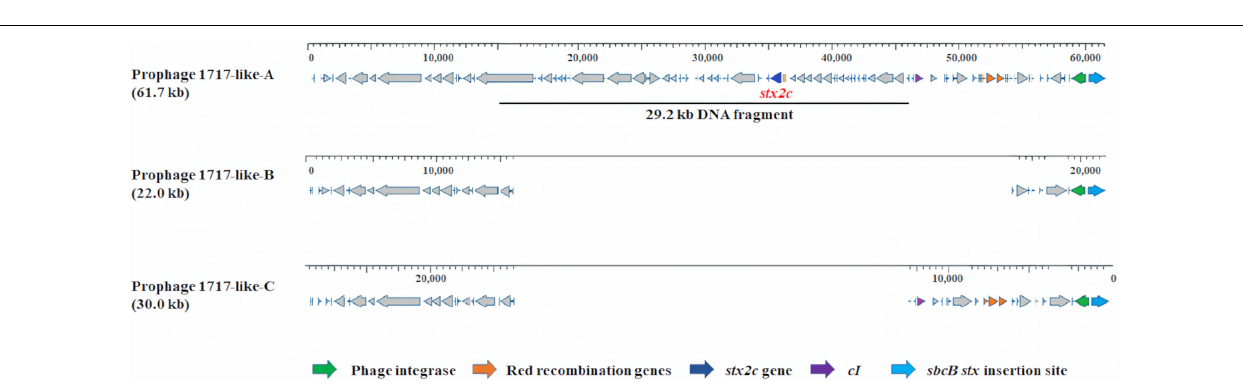
FIGURE 3 | Prophage comparison at sbcB stx insertion sites in Escherichia coli O157:H7 strains used in this analysis. The stx2c -carrying prophages 1717-like-A was present in strain C1-010 ( stx1 − , stx2c +). The stx -negative prophages 1717-like-B and 1717-like-C were present in strains CV261 and NZRM3614, respectively. A 29.2 kb DNA fragment containing the stx2c gene was present in prophage 1717-like-A in strain C1-010, but this DNA fragment was absent in the stx -negative prophages 1717-like-B and 1717-like-C in strains CV261 and NZRM3614,